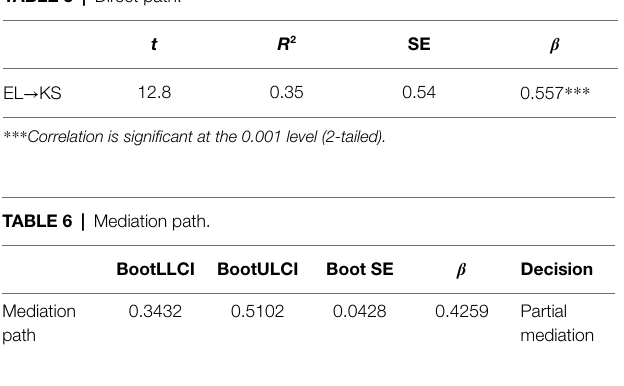
TABLE 7 | Results of the moderated path analysis.